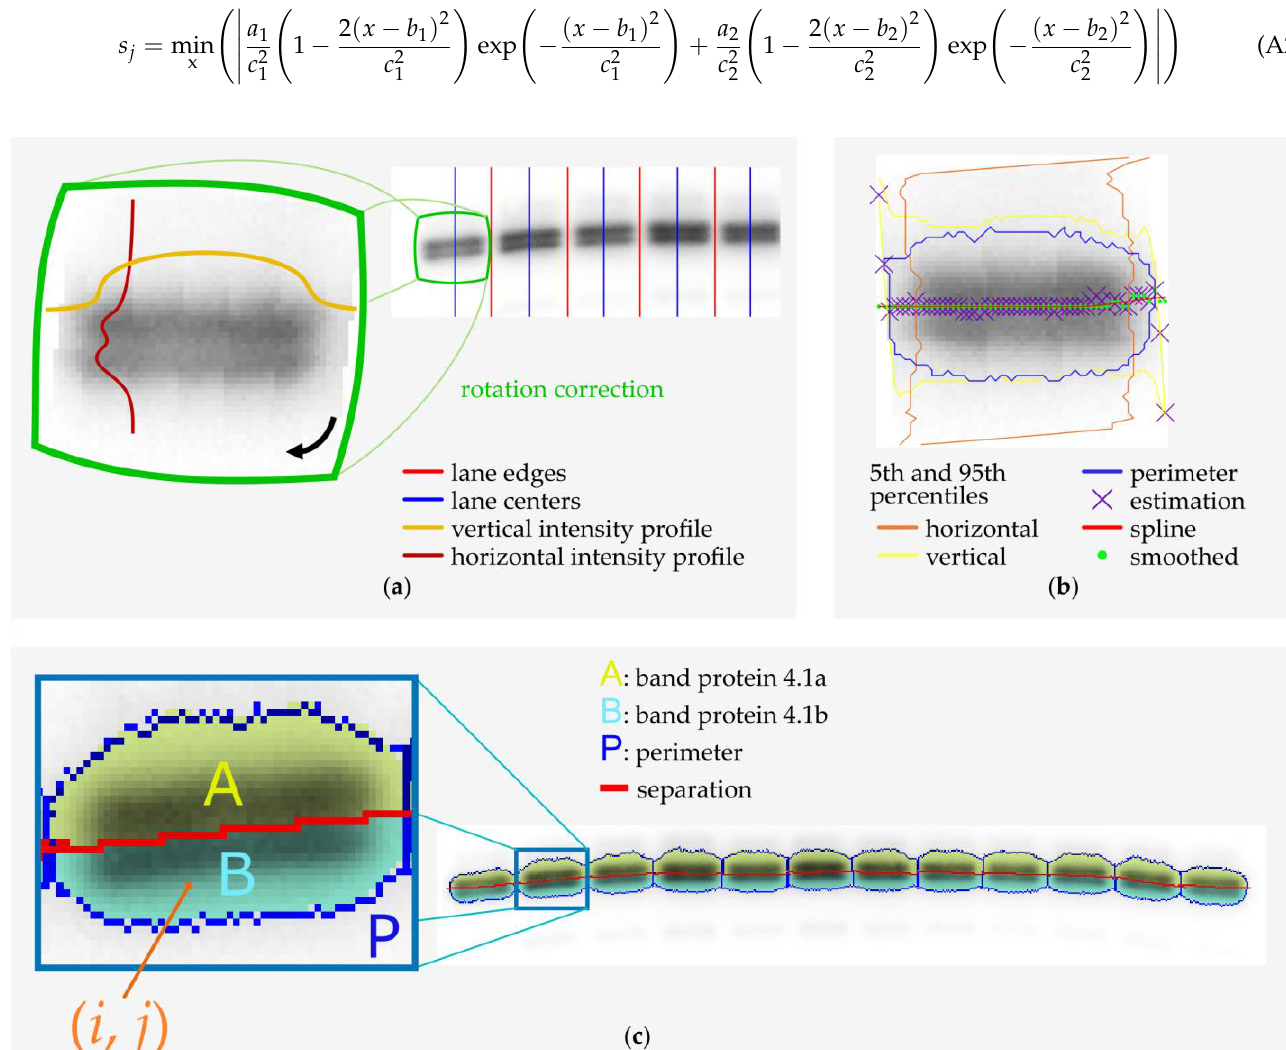
Figure A1. Scheme of the automated image analysis algorithm. ( a ) Intermediate edges and lane positions are detected, each pair of bands is isolated and rotated for alignment; horizontal and vertical intensity profiles are extracted; a double-gaussian is fitted to the latter. ( b ) The 5th and 95th percentiles of the profiles along each axis are determined and combined to compute a perimeter; separation points are estimated from the double-gaussian. A spline regression is carried out to discard outliers; a smoothed discrete edge is deduced. From ( b , c ) an inverse coordinate transformation is applied to fit the perimeter and separation edge on the raw data.